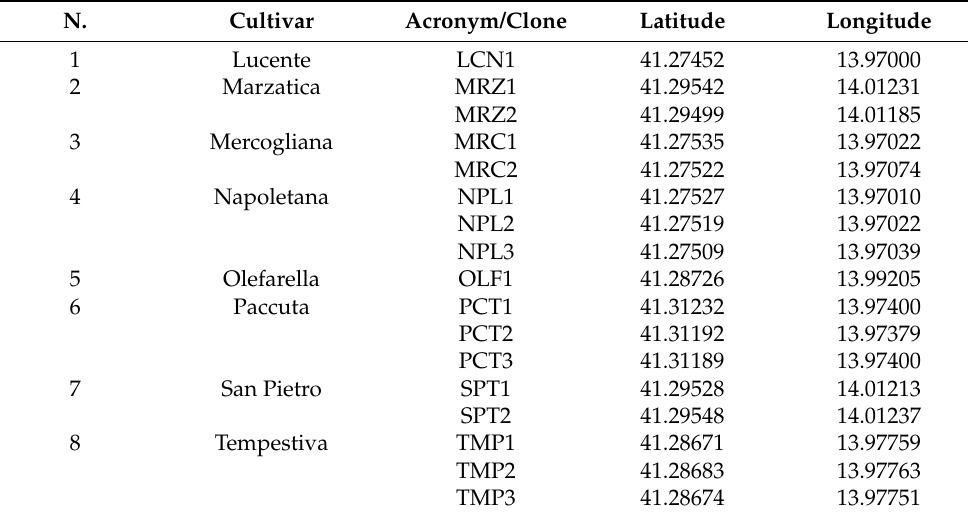
Table 1. Sampling of 17 individual trees from eight renowned C. sativa cultivars in the Regional Park “Volcanic Area of Roccamonfina and Foce Garigliano”, Campania (Italy). N. Cultivar Acronym/Clone Latitude Longitude 1 Lucente LCN1 41.27452 13.97000 2 Marzatica MRZ1 41.29542 14.01231 MRZ2 41.29499 14.01185 Mercogliana MRC1 41.27535 Napoletana NPL1